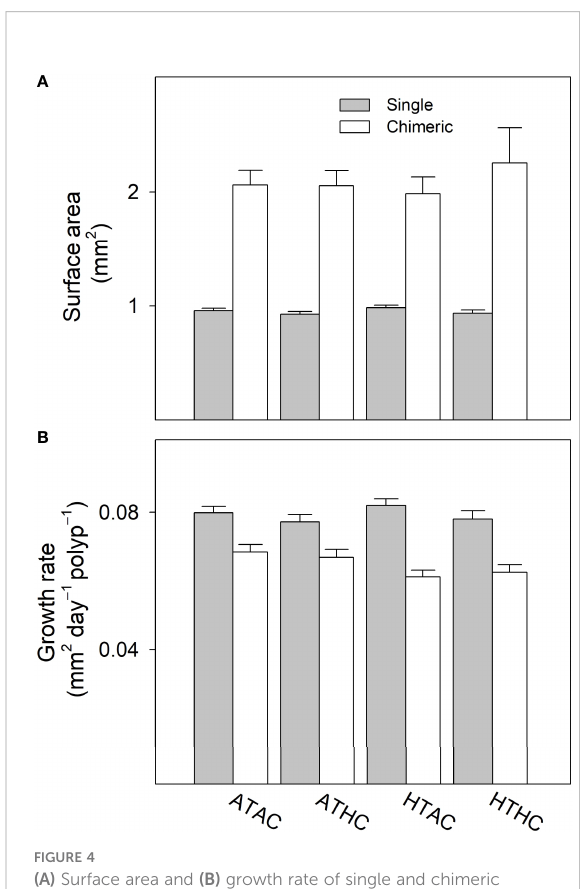
FIGURE 4 (A) Surface area and (B) growth rate of single and chimeric Acropora austera recruits under combinations of temperature (28°C, 30.5°C) and p CO 2 (~500 m atm, ~1000 m atm). Data are presented as mean ± SE (n = 60 and 30 for single and chimeric recruits, respectively). Experimental treatments: ambient temperature – ambient p CO 2 (ATAC), ambient temperature – high – ambient p CO p CO 2 (ATHC), high temperature 2 (HTAC) and high temperature – high p CO 2